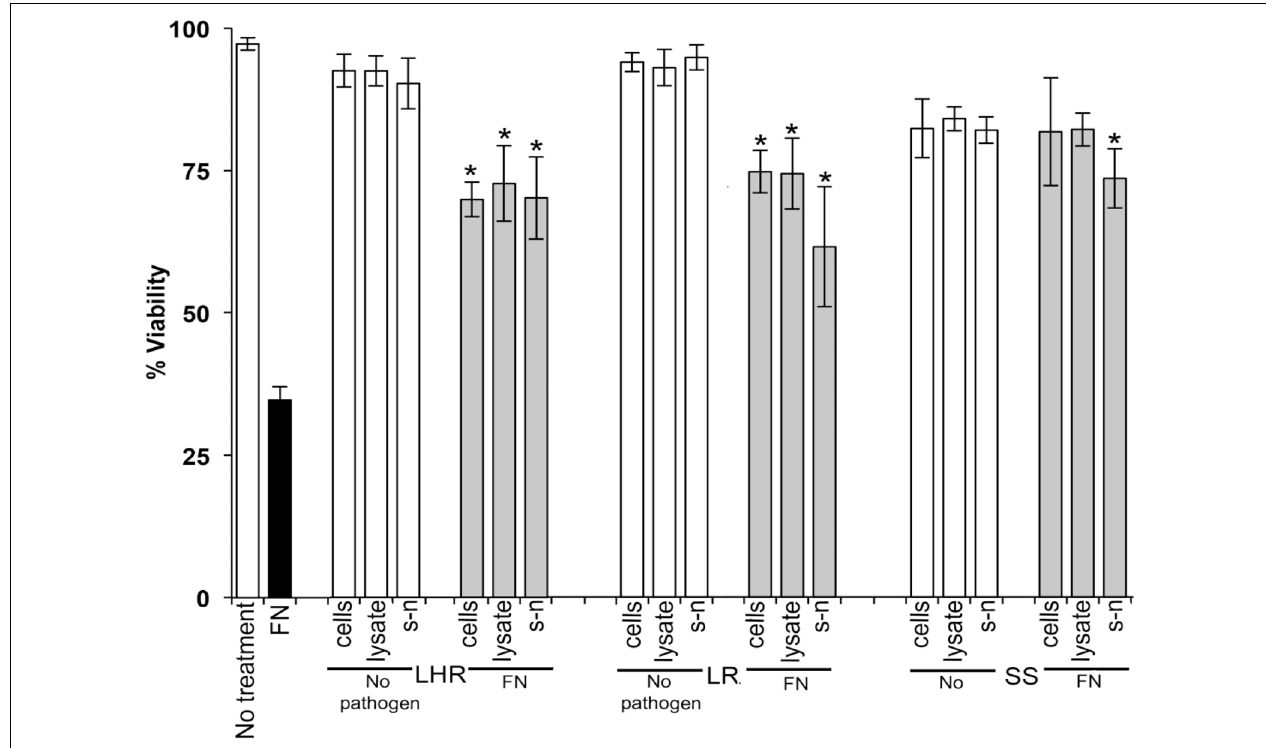
FIGURE 3 | The protective effects of candidate probiotics for human oral keratinocytes against F. nucleatum. All probiotic cells, cell lysates, and culture supernatants protect HOKs against F. nucleatum . HOKs were inoculated with either live L. rhamnosus GG (LHR), L. reuteri (LR), or S. salivarius K − 12 (SS) lysates and supernatants (s-n) (white bars) or simultaneously in combination with F. nucleatum (FN) (gray bars). All experiments were performed for a minimum of three biological replicates, with three technical replicates each time. All data are shown as mean values plus/minus standard deviations. Results expressed as the mean ± SEM, * p <